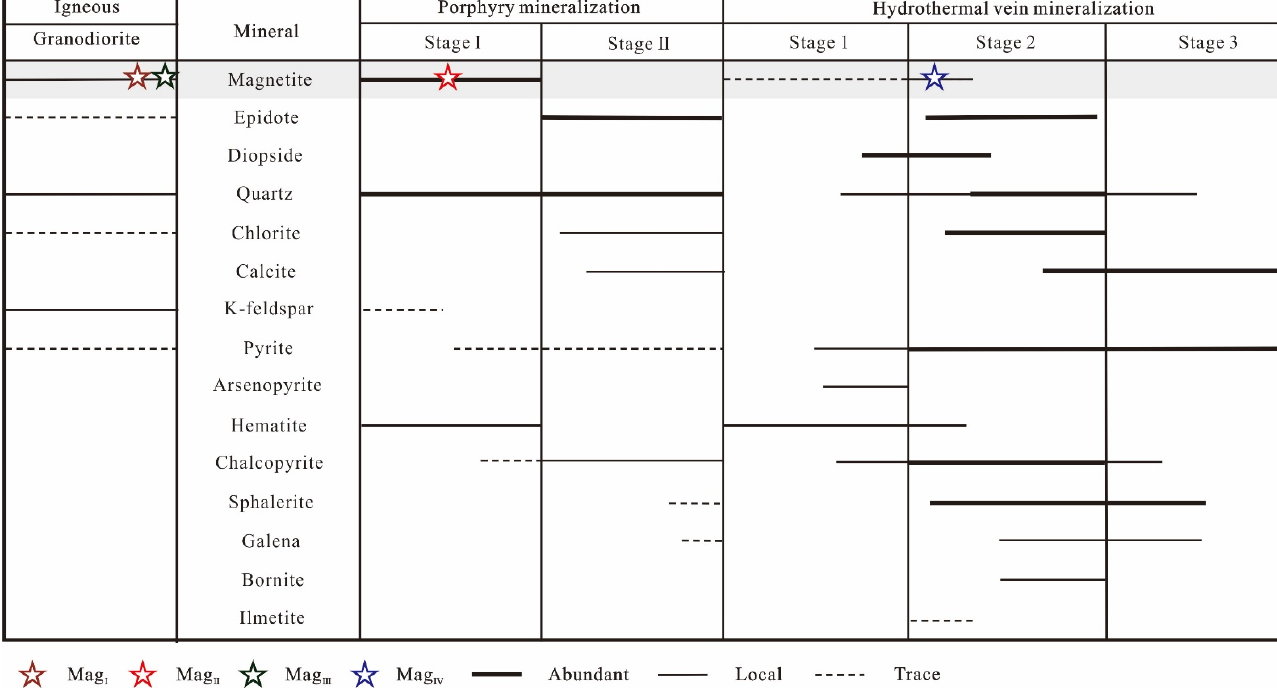
Figure 4. Mineral paragenesis at the Tonggou deposit, showing hydrothermal magnetite.